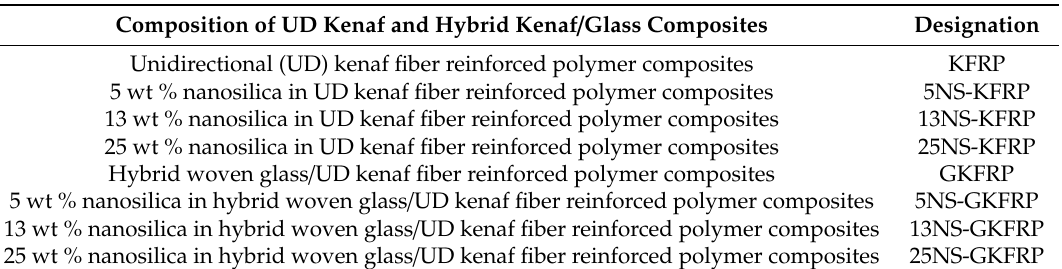
Table 1. The designation of unidirectional (UD) KFRP and hybrid woven glass / UD kenaf fiber reinforced polymer (GKFRP) composites with three di ff erent nanosilica